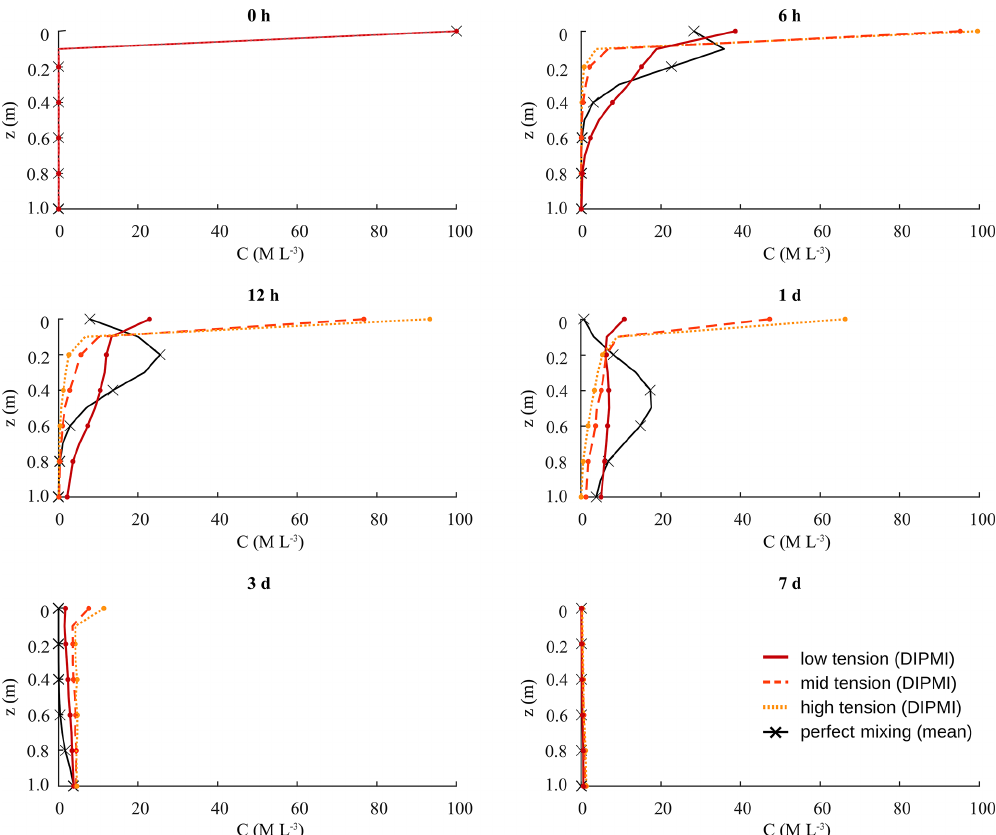
Figure 4. Vertical concentration profiles of a solute with mean concentrations in three tension areas over 7d, simulated by the DIPMI approach with pore-size-distributed D values (red shades) and the perfect mixing assumption (black), respectively. Note that the black line and crosses illustrate the same mean concentration in all three tension areas per soil layer, as the perfect mixing assumption averages out pore-size-dependent